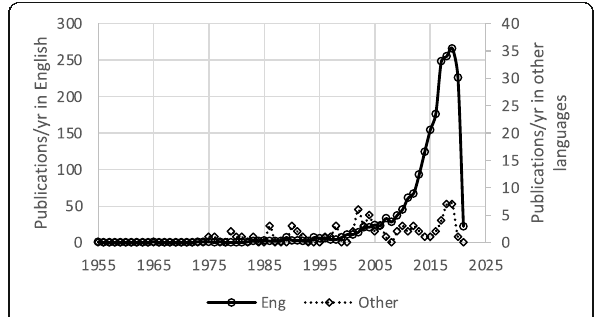
Fig. 3 Number of papers on PND published annually from 1955 to date in English and other